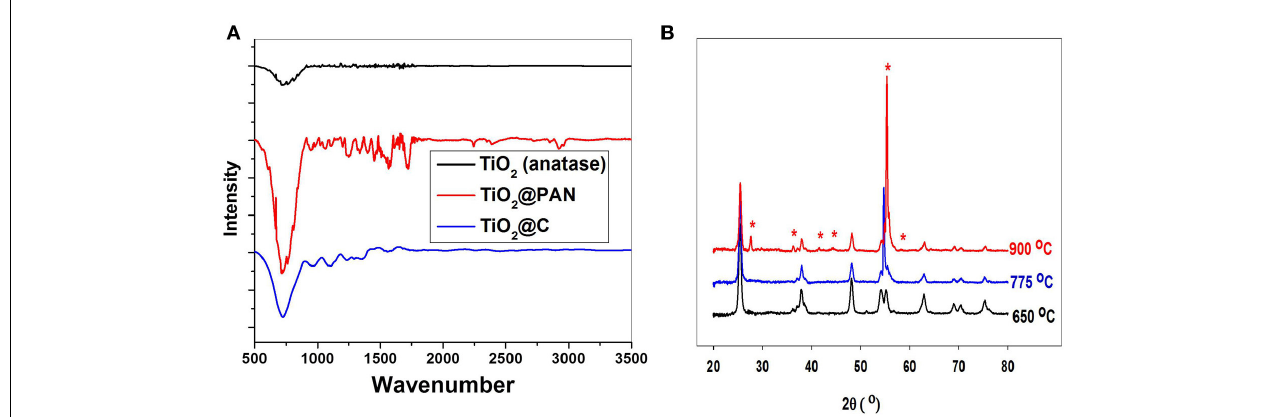
FIGURE 4 | (A) FTIR of anatase nanoparticles A1, before encapsulation, after polymer encapsulation and after carbonization at 775 ◦ C. (B) X-ray diffraction of TiO 2 @C (sample A2) after carbonization at three different temperatures. The peaks marked with a star correspond to rutile crystallites.